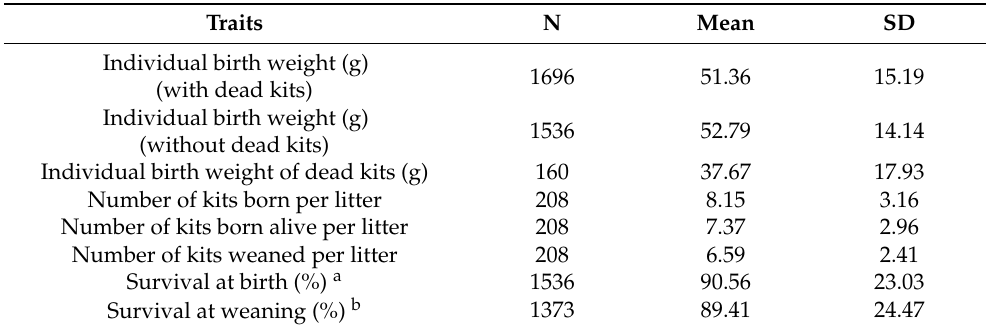
Table 2. Number of observations (N), means and standard deviations (SD) of individual birth weight, litter size and kit survival traits.